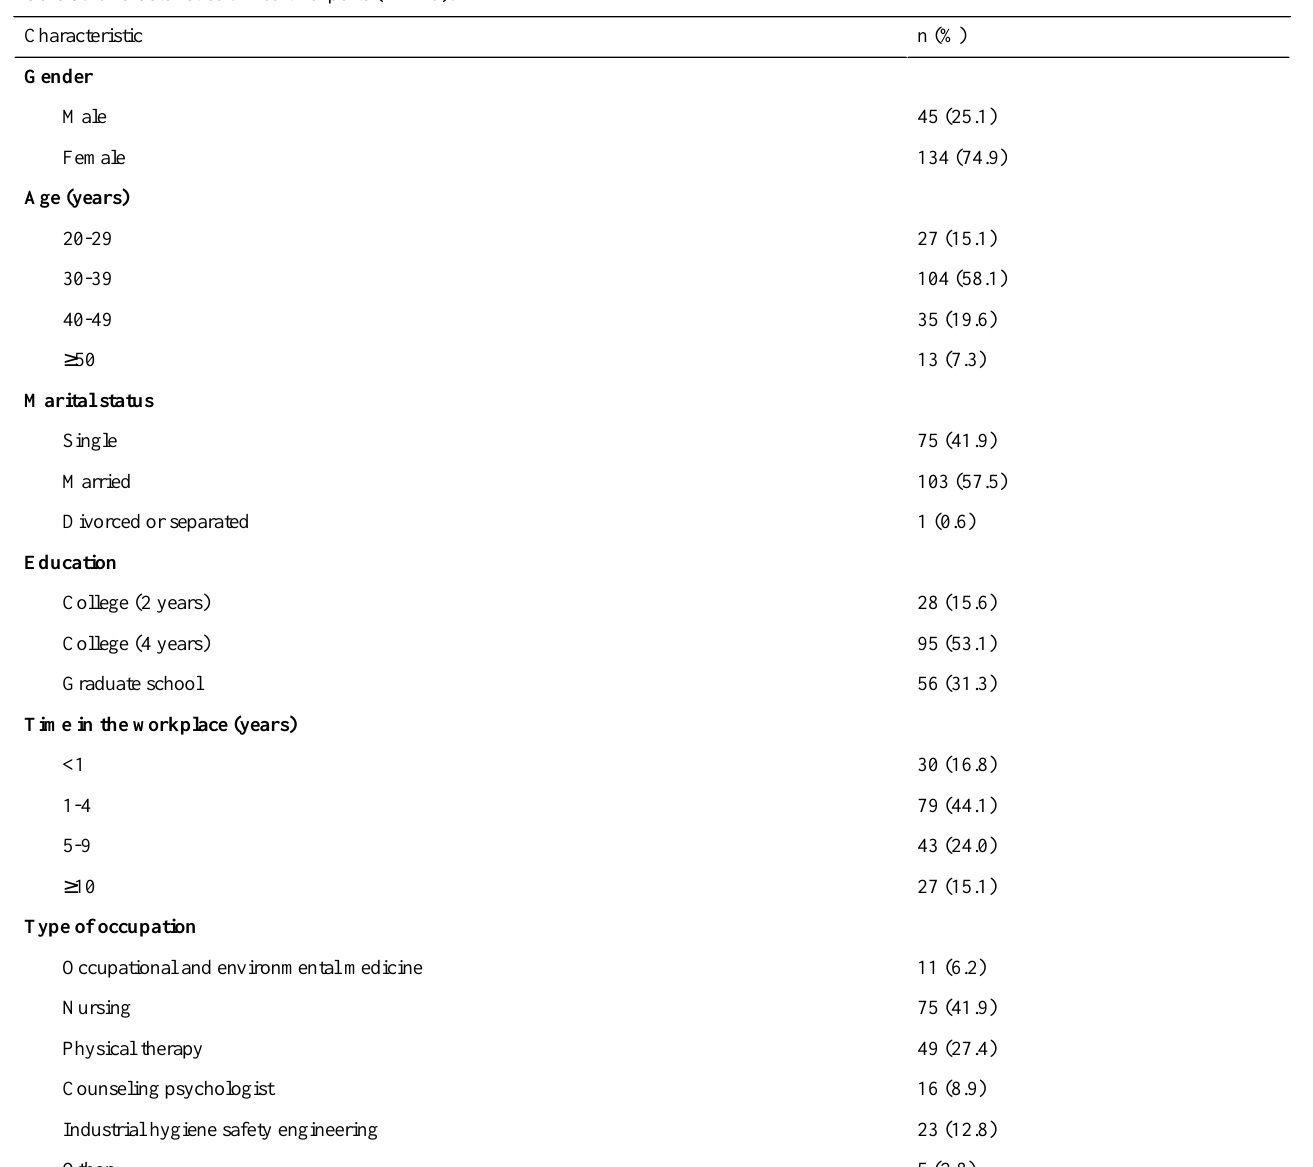
Table 3. Characteristics of health experts